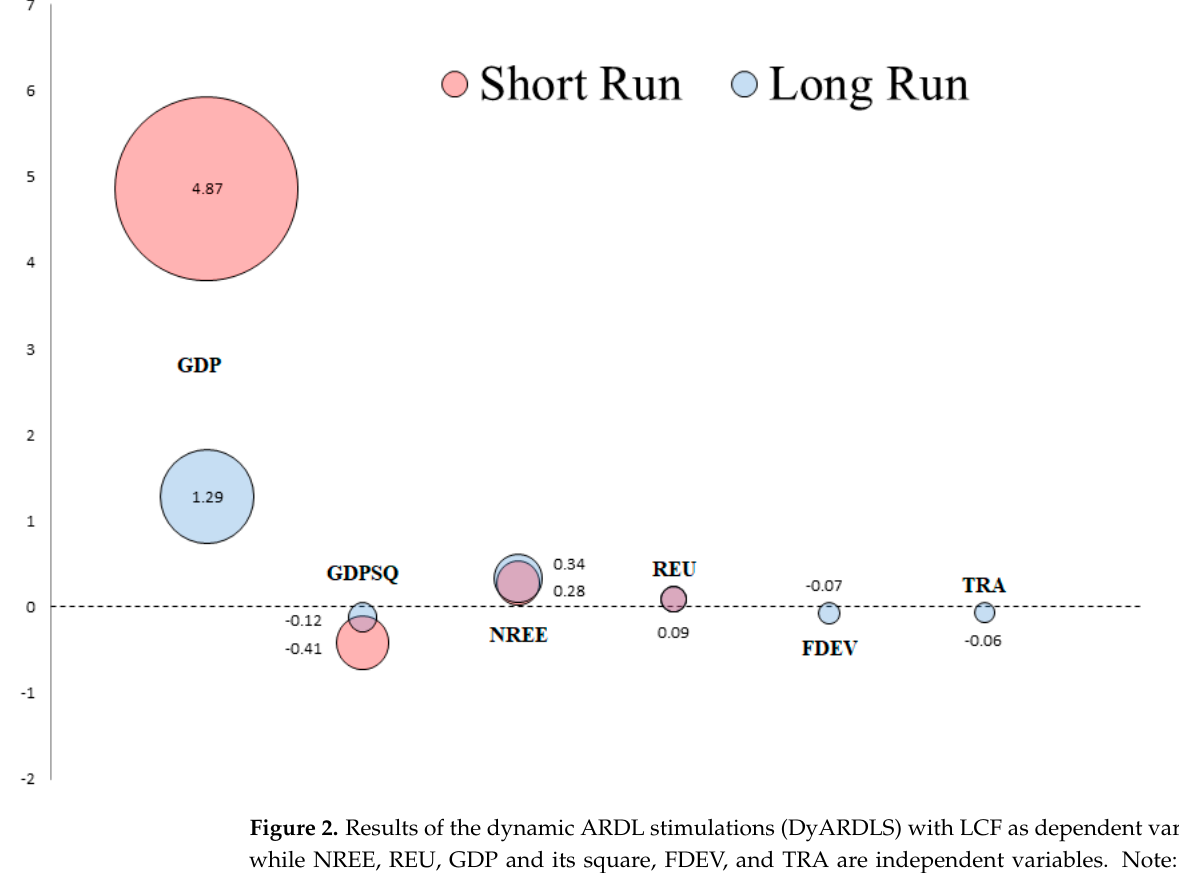
Figure 2. Results of the dynamic ARDL stimulations (DyARDLS) with LCF as dependent variable, while NREE, REU, GDP and its square, FDEV, and TRA are independent variables. Note: This figure presents the statistically significant short- and long-run coefficients estimated by the DyARDLS approach.